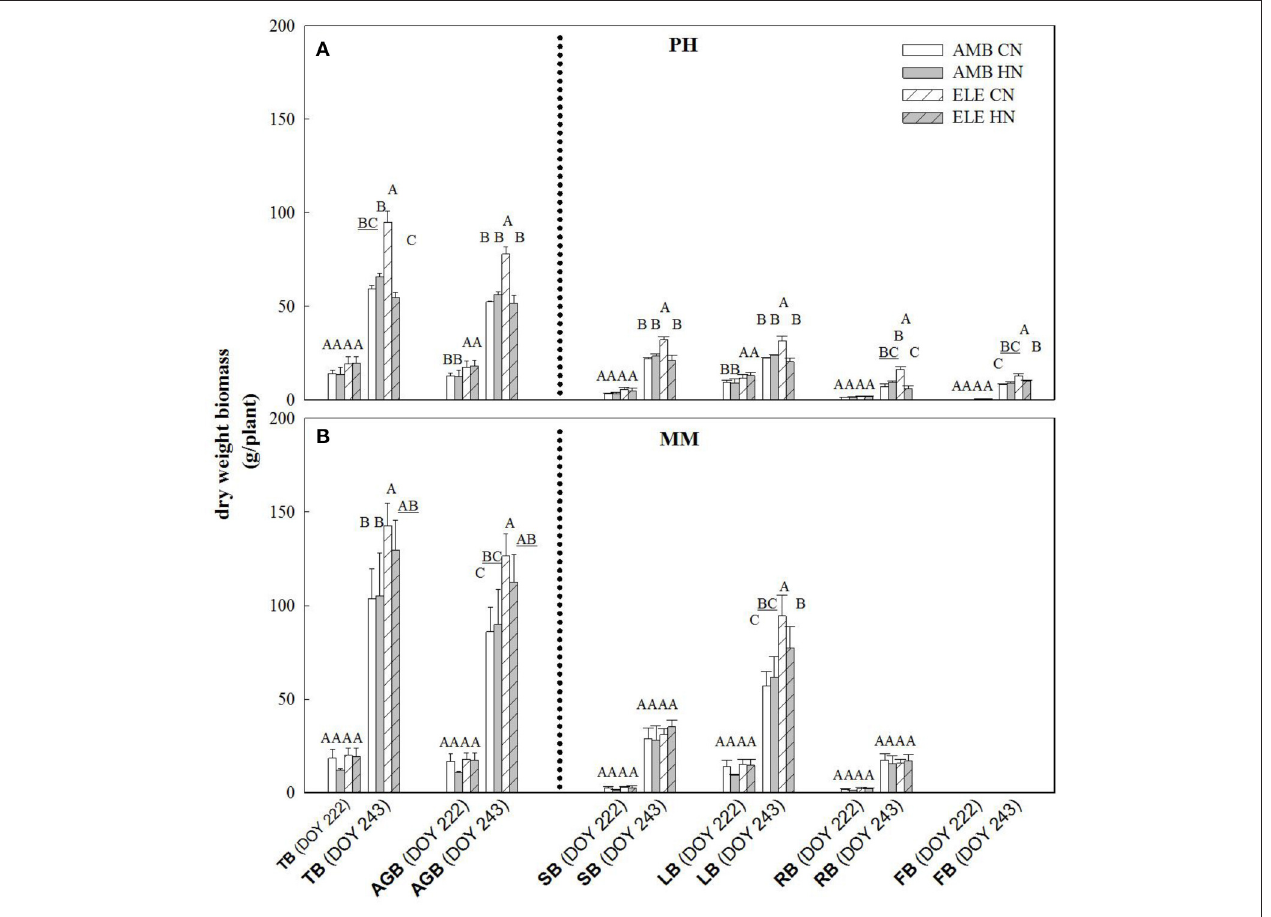
FIGURE 4 | Total (TB), above-ground (AGB), stem (SB), leaf (LB), root (RB) and flower (FB) biomass for PH (A) and MM (B) tobacco cultivars. The day of the year (DOY) for the two harvests are in parenthesis. Bars represent the average values for each treatment. Cultivars, treatments, error bars and letters above each bar are as in Figure 1